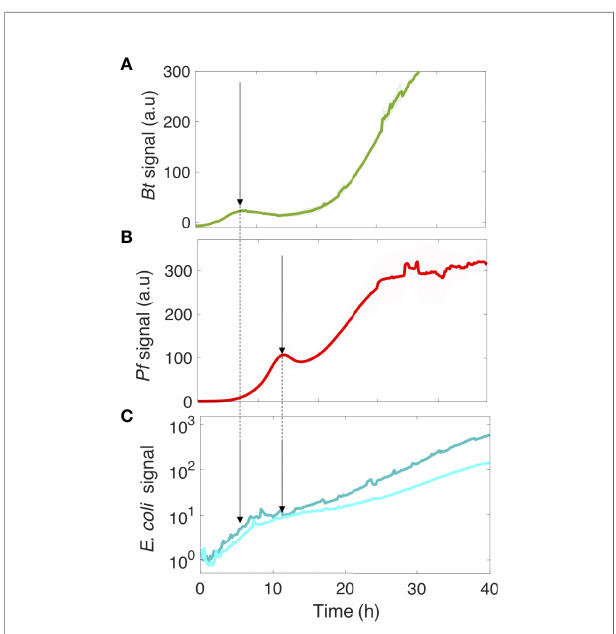
FIGURE 6 | The kinetics of motile and nonmotile E. coli surface colonization follows the community development timing of the four species. Bt (A) and Pf (B) surface development kinetics in the four-species community. In parallel, the logarithmic display of the E. coli signal on the surface is shown in the presence of the co-colonizers (C) . The arrows point to the Bt (A) and Pf (B) initial climaxes, and the E. coli development phases (C) . Curves are from the average intensity of 2 distinct positions in 3 different channels (3 biological replicates) with the shaded area representing the standard